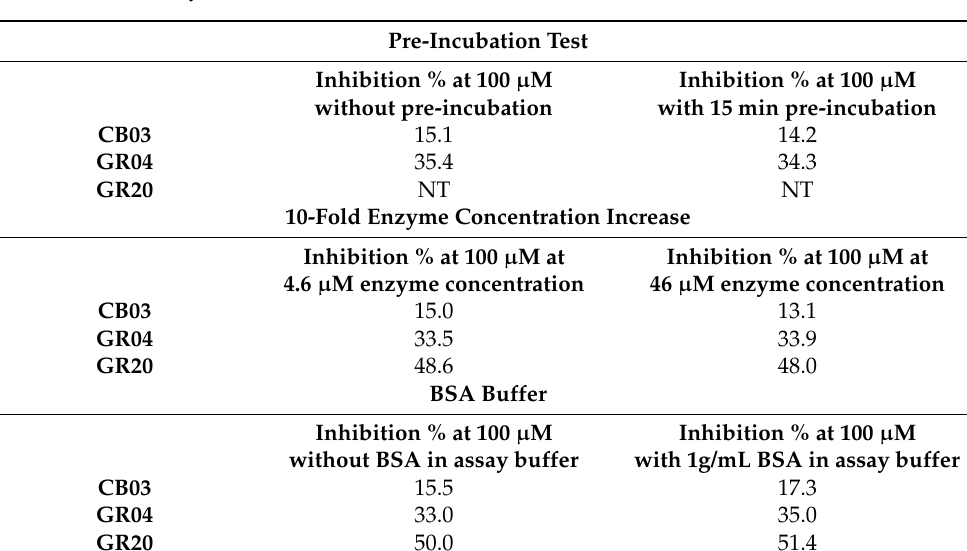
Table 3. Promiscuity tests results (NT: not